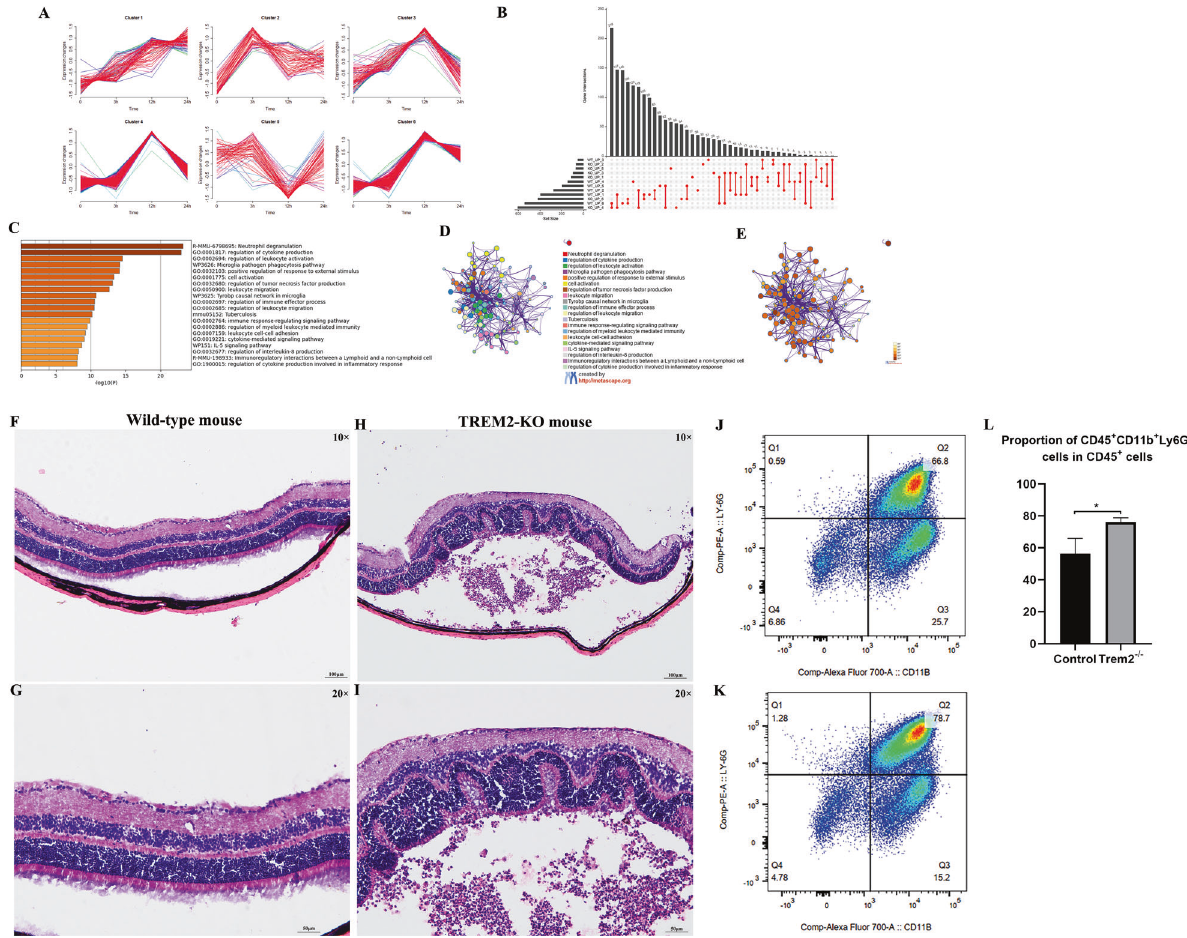
Fig. 4 Trem2 de fi ciency advances the peak time of in fl ammatory response and accelerates immune cell in fi ltration. A Time-course transcriptional pro fi les of up-regulated DEGs in Trem2 − / − mouse retina within 24 h after RD. B UpSet plot showing that Cluster 6 of WT and Cluster 4 of Trem2 − / − contain the most overlapped genes (218 out of 540), suggesting that the same genes are activated earlier in Trem2 − / − mouse following RD. C The top 20 GO terms and pathways over-represented by the 218 overlapped genes. D Network of enriched terms colored by cluster ID. E Network of enriched terms colored by p value. Representative histopathological images of WT ( F , G ) and Trem2 − / − ( H , I ) mouse after RD indicates that Trem2 − / − mice exhibit extensive retinal folds with numerous in fi ltrated neutrophils accumulation at the grooves. Scale bar, 100 μ m (10×) and 50 μ m (20×). Representative fl ow cytometry plots showing the gating strategy for neutrophils (CD45 + CD11b + Ly6G + ) in the WT ( J ) and Trem2 − / − ( K ) mouse after RD. L Quanti fi cation analysis of the fl ow cytometry indicates that a higher percentage of neutrophils was observed in Trem2 − / − mouse Trem2 − / − retina at 0, 3, 12, and 24 h after RD (Additional fi le 1: Table S11). Mfuzz time clustering of the Upregulated DEGs yielded six clustered (Fig. 4A). We analyzed the gene intersections of each